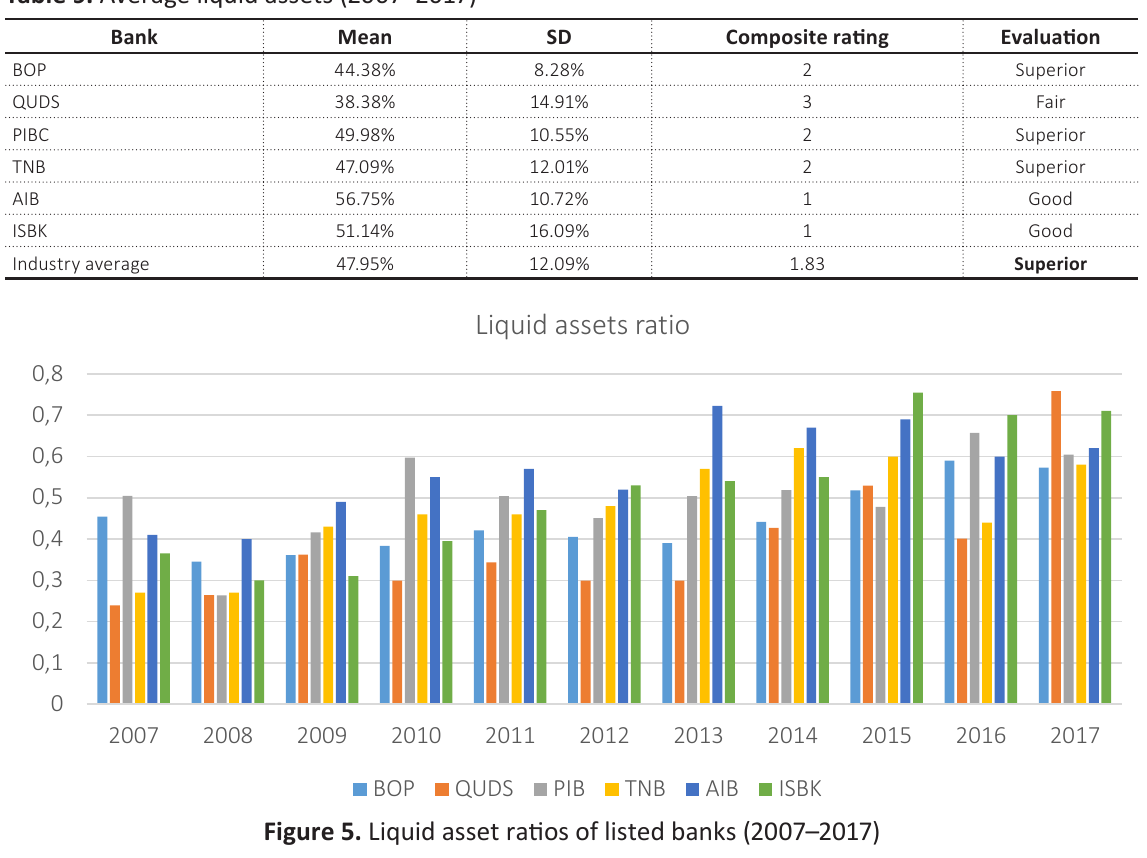
Figure 5. Liquid asset ratios of listed banks